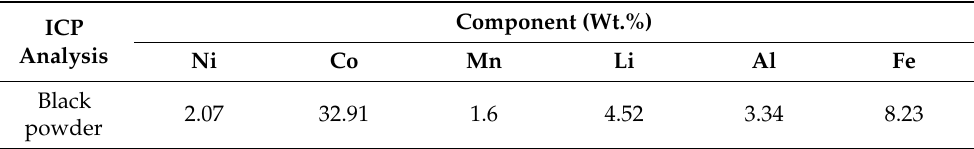
Table 2. Spent lithium-ion battery (LIB) powder ICP analysis